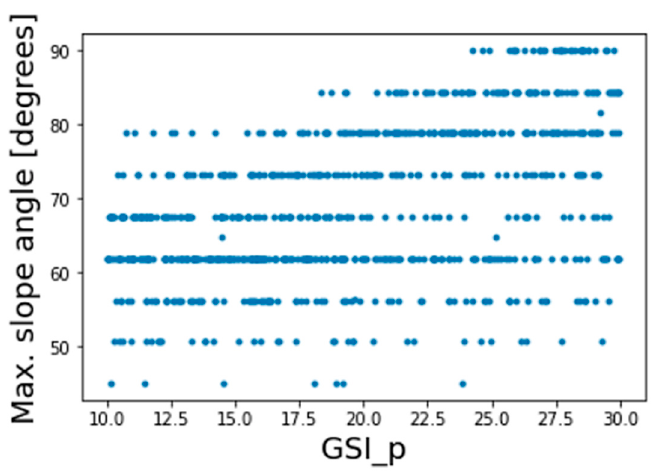
Figure 7. Distribution of maximum slope angle for the FE models.